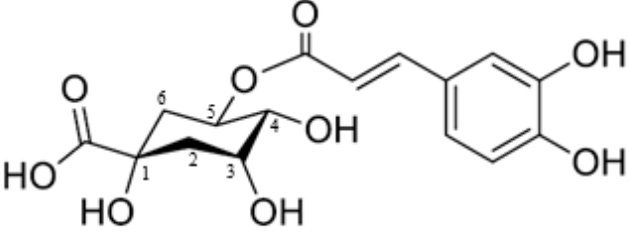
Figure 1. Chemical structure of chlorogenic acid (5- O -caffeoylquinic acid).